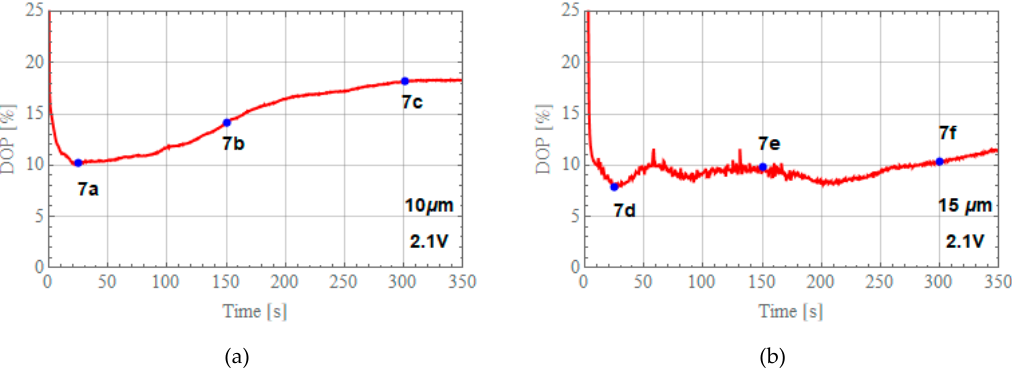
Figure 8. Time evolution of measured DOP at different applied voltages to PVAN cells with thickness of: ( a ) 10 μ m and ( b ) 15 μ m. The SOP of the incident light is linearly H polarized.